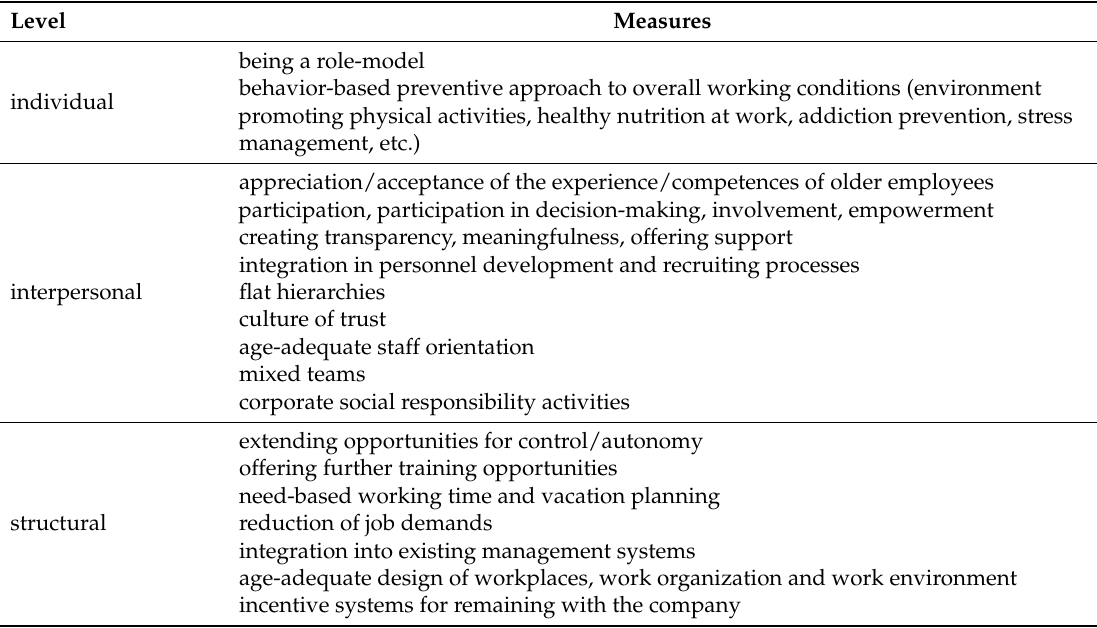
Table 1. Concrete measures that may be applied as part of an age management program to maintain and strengthen work